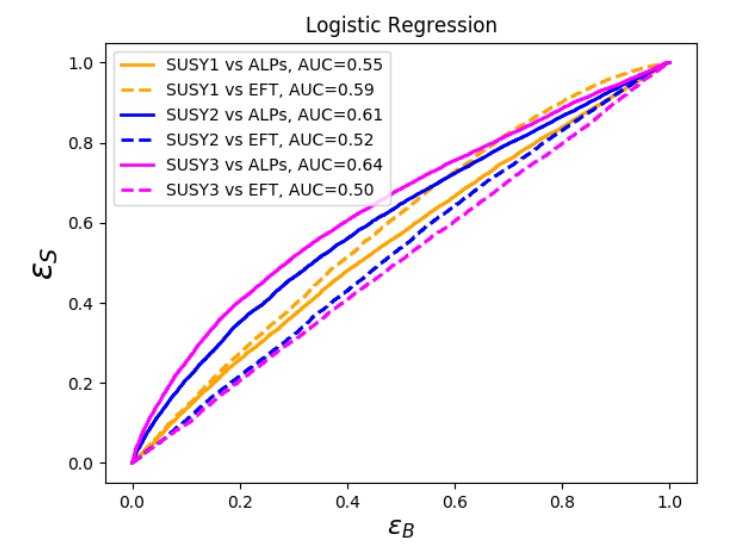
Figure 4: ROC curves using logistic regression for different WIMP scenarios versus ALP / EFT signals (monojet